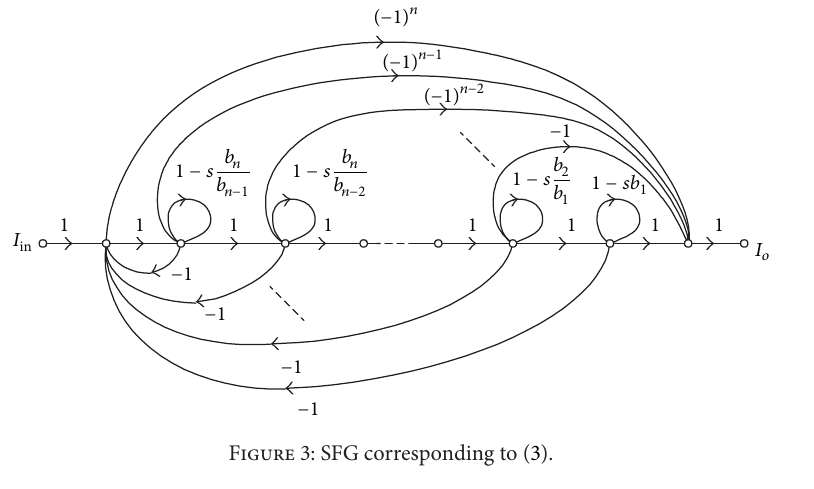
Figure 3: SFG corresponding to (3).